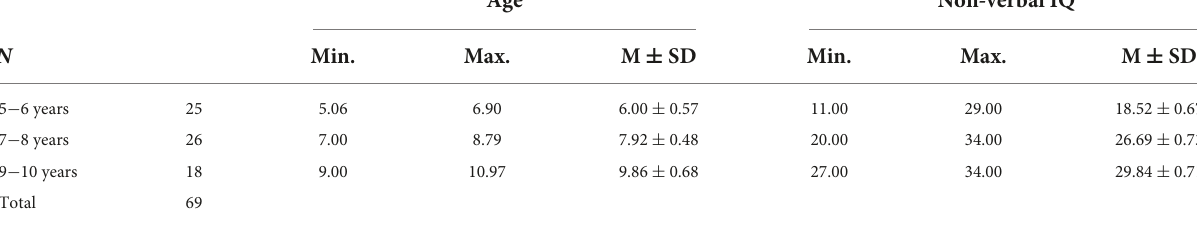
TABLE 1 Descriptive statistics of the mean age ( ± SD) and IQ raw scores measure for each age group. Age Non-verbal IQ N Min. Max. M ± SD Min.